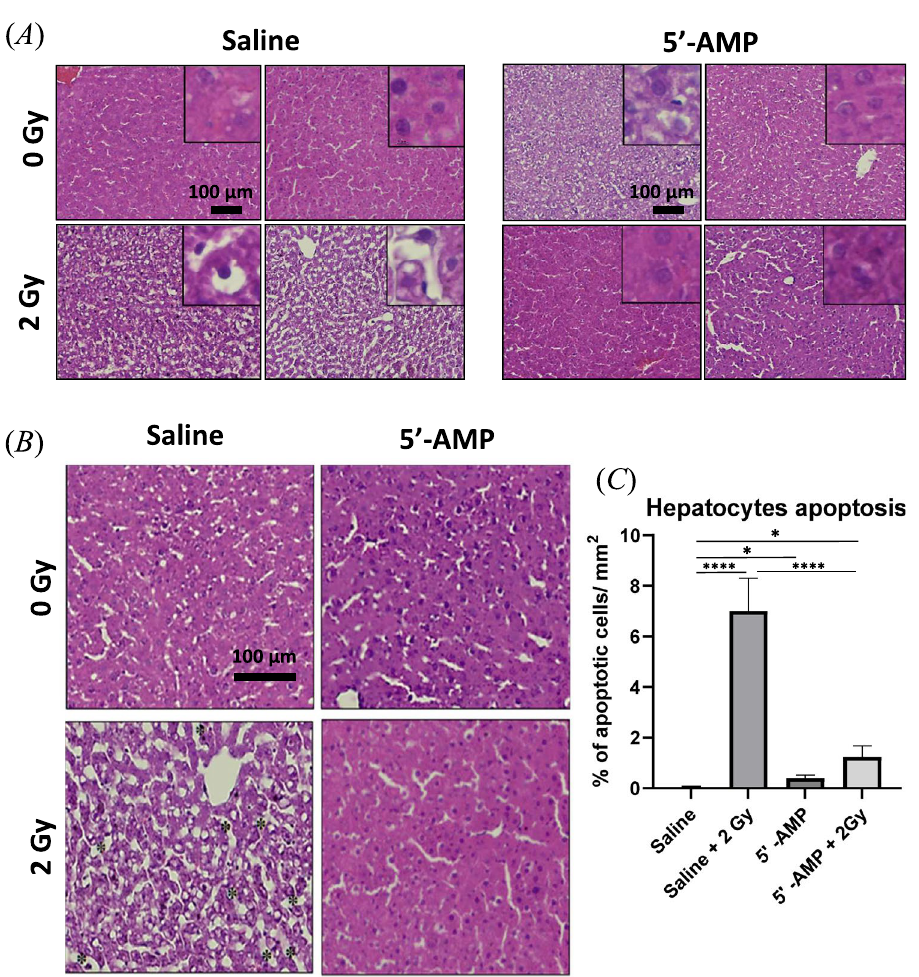
Figure 3. The 5 ′ -AMP administration in rats suppresses the radiation-induced liver damage. ( A ) Irradiation- induced alteration in hepatocytes’ nuclei, cytoplasm (pyknosis). ( B ) Sinusoidal dilatation (asterisk) was observed on saline-injected irradiated rats, while the 5 ′ -AMP administrated rats had preserved histology. ( C ) The increased number of pyknosis cells in the liver tissue of irradiated rats compared to those irradiated and treated with a 5 ′ -AMP injection. Data are presented as the mean SEM. * P < 0.05; **** p < 0.0001. Sham treatment, n = 9 ROI (3 animals); 5 ′ -AMP, n = 9 ROI (3 animals); Saline + 2 Gy , n = 9 ROI (3 animals); 5 ′ -AMP + 2 Gy , n = 12 ROI (4